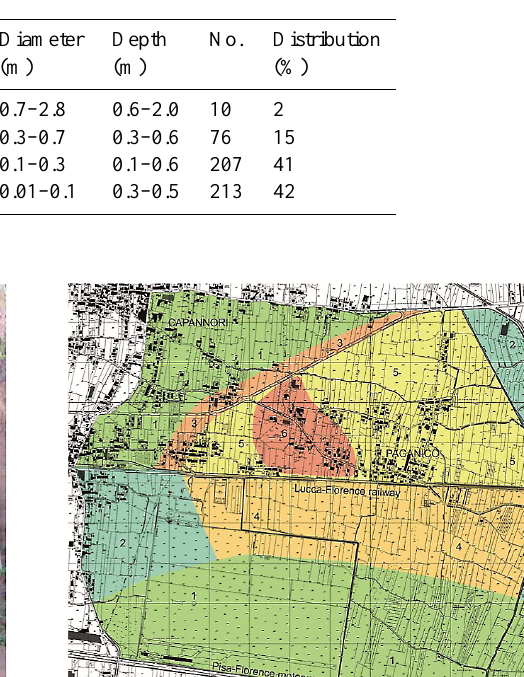
Table 1. Morphometric characteristics of the Paganico cavities and relative distribution.